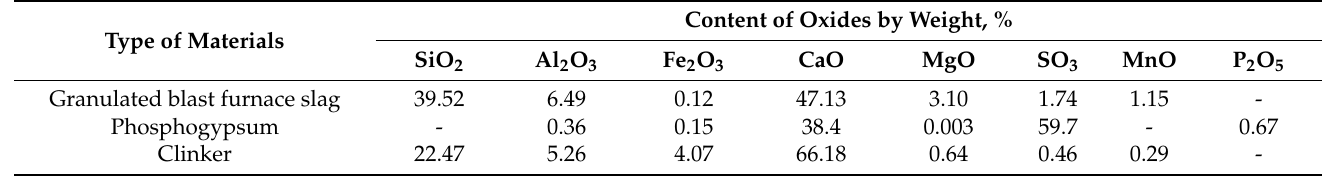
Table 2. Chemical composition of the initial